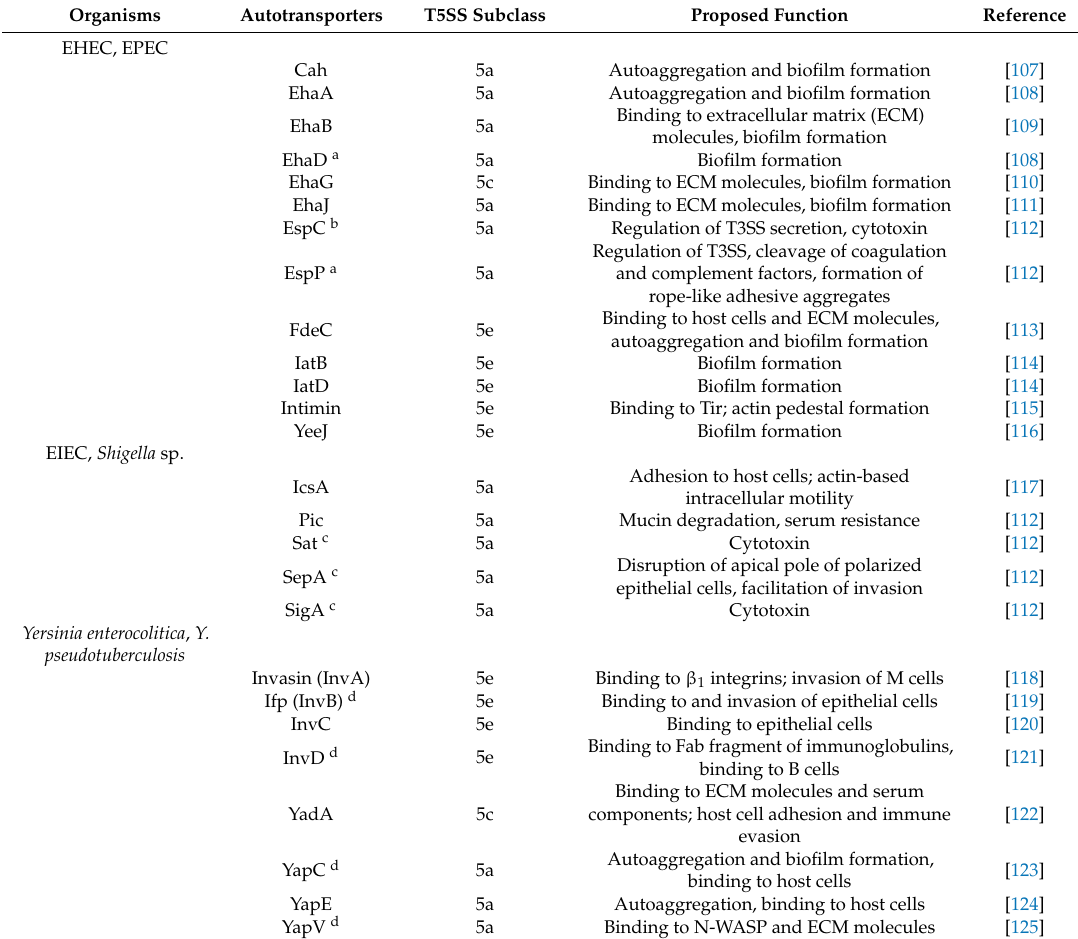
Table 2. Characterized autotransporters of pathogenic